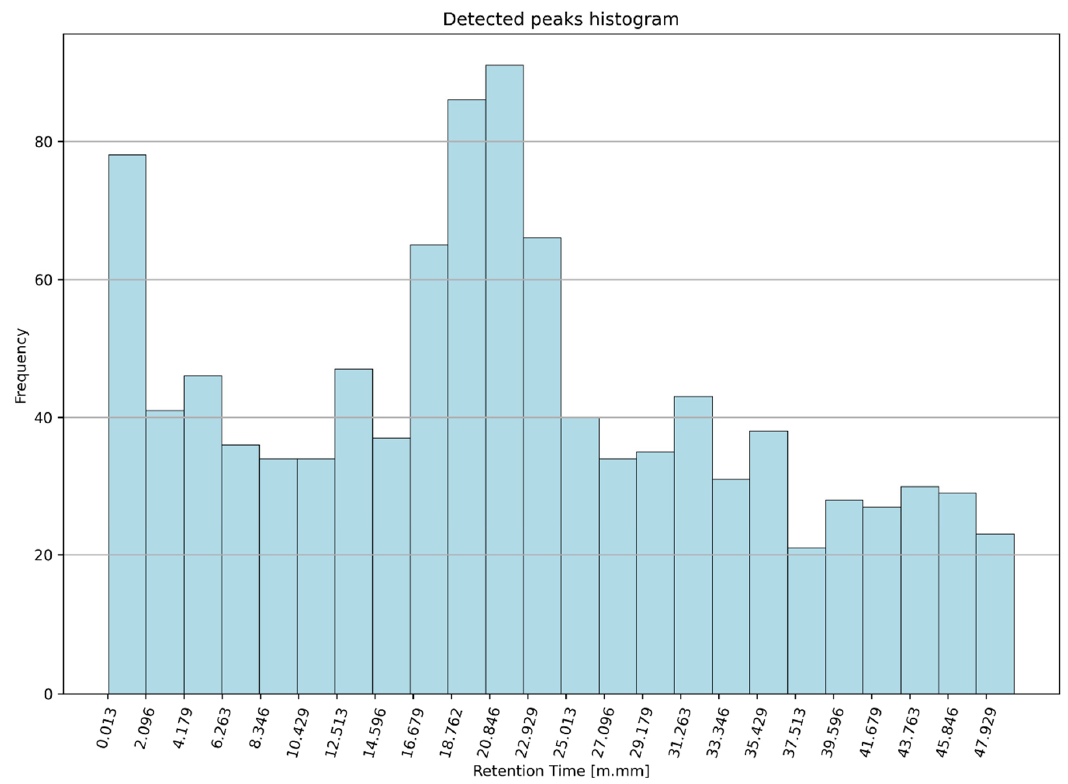
Figure 3. Histogram of the detected peaks for the entire group of PAH